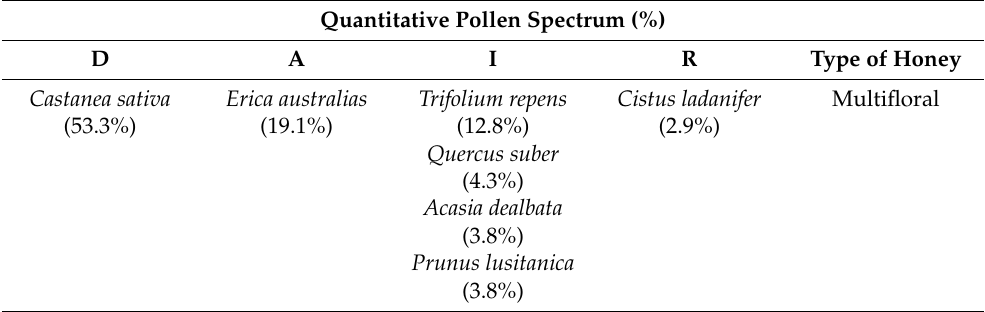
Table 2. Botanical origin of honey: dominant pollen (D) >45% of the pollen spectrum; accompanying pollen (A) representing 15–45%; important pollen (I) 3–15%; minor pollen (R) 1–3%. Quantitative Pollen Spectrum (%)